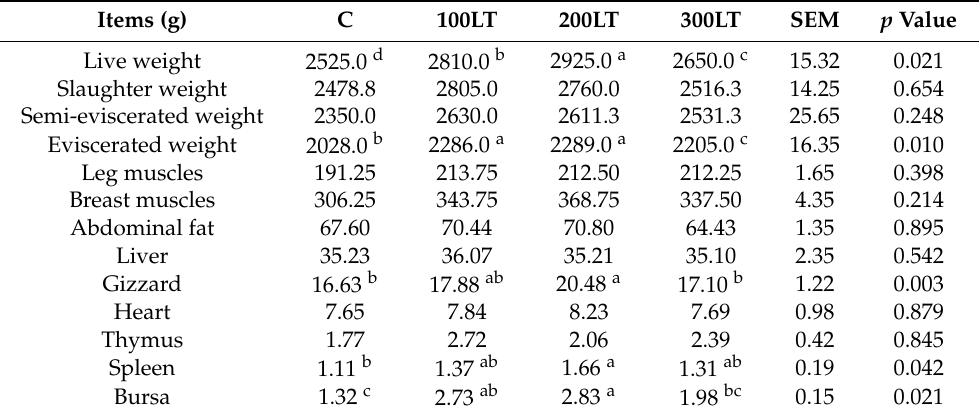
Table 2. Carcass traits and weight of immune organs of broilers as affected by dietary L -theanine supplementation at 42 days of